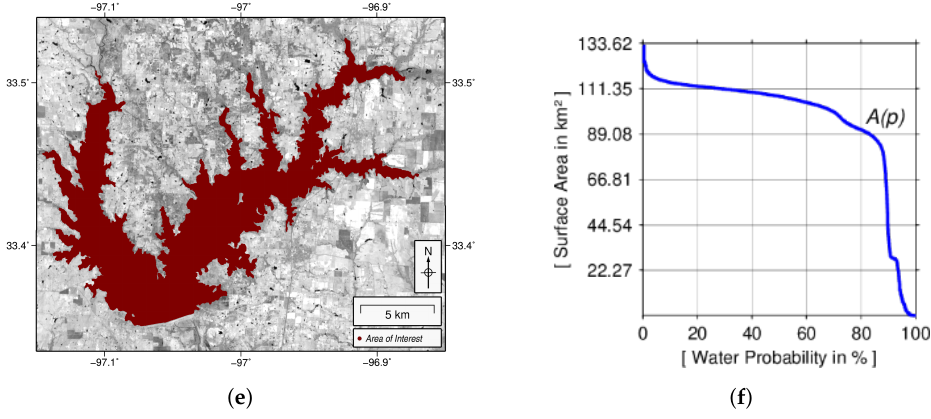
Figure 10. ( a ) Number of water pixels of all accumulated monthly files ( b ) Number of water and land pixels of all accumulated monthly files ( c ) Water probability mask ( d ) Labeling of connected surfaces ( e ) Mask of interested water body ( f ) Dependency between water probability and area